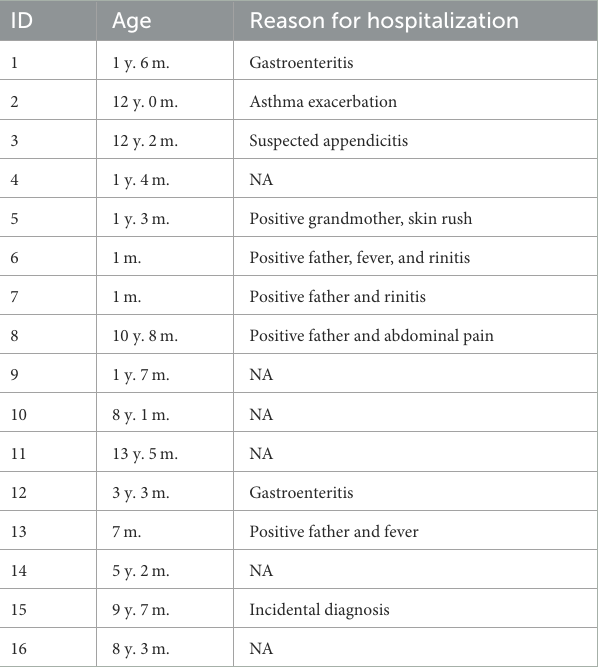
TABLE 1 Anagraphical and sanitary information of positive